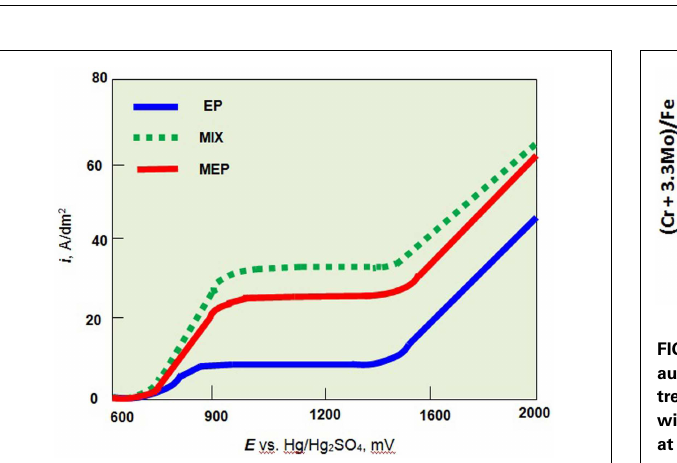
FIGURE 3 |Anodic polarization curves of austenitic stainless steel (AISI 316L SS) in H 2 SO 4 :H 3 PO 4 = 2:3 solution at temperature 60°C without stirring (EP), with stirring (MIX), and in the magnetic field (MEP) .